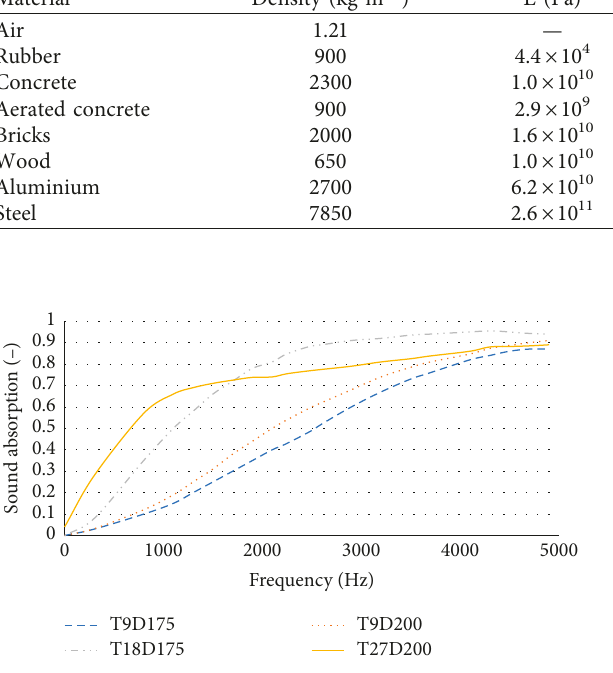
Figure 2: Results from the absorption coefficient of basalt layers from the study by Moretti et al.